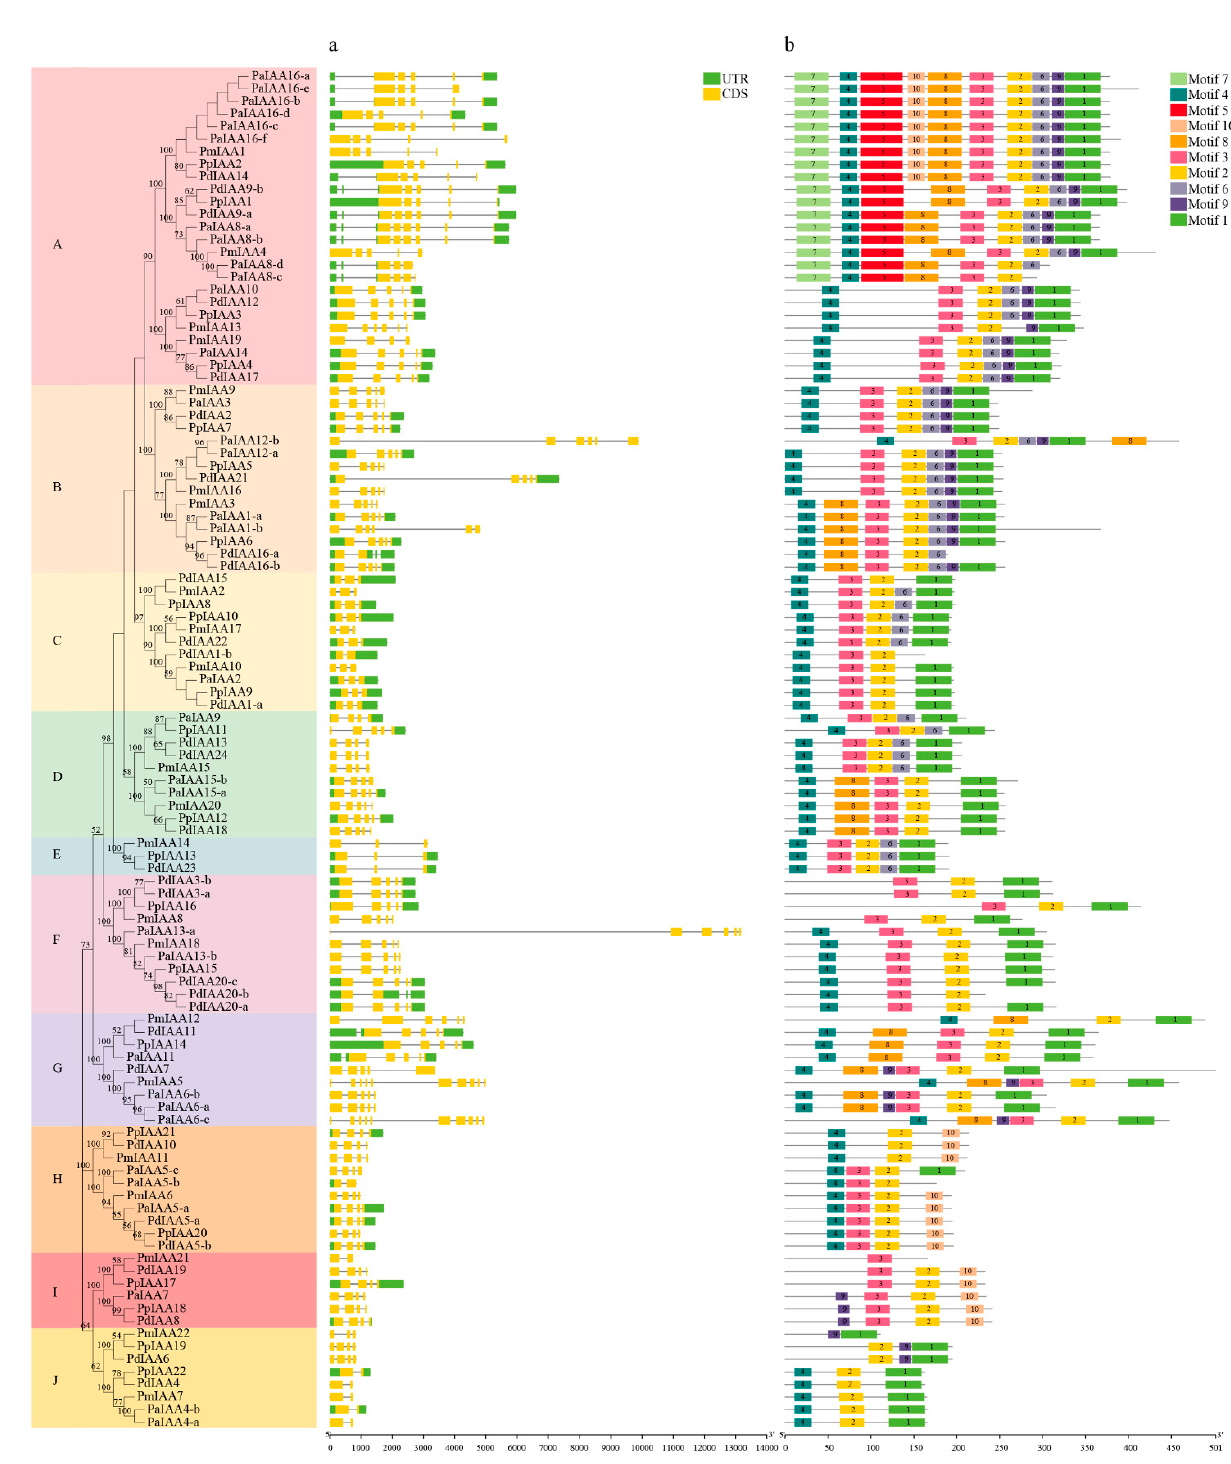
Figure 2. Gene structure and motif compositions of RoIAAs from Rosaceae based on phylogenetic tree. In phylogenetic tree, groups A–J are in the same color box. ( a ) Exons and introns structure of RoIAAs . The yellow rectangle shows exon, the green rectangle exhibits nontranslate area, and the black line represents intron. Length of exons could be inferred by the scale at the bottom. ( b ) Conserved motifs in RoIAAs. Each motif is shown by one color box. Details of motifs 1–4 are referred to Supplementary Figure